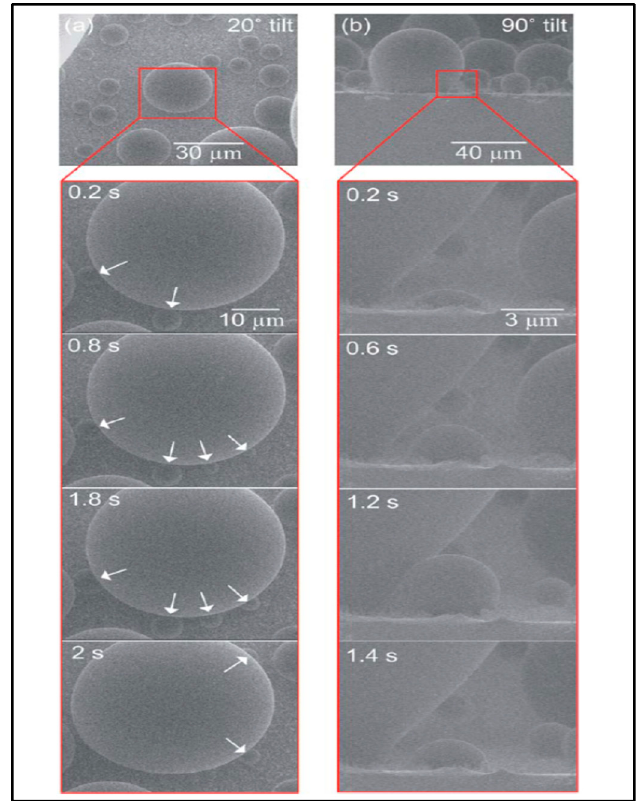
Figure 4. Location of small micro–nanoscale satellite drops adjacent to primary drops as shown by white arrows. Images taken by Environmental Scanning Electron Microscopy (ESEM) at ( a ) 20° and ( b ) 90° tilt on a super hydrophobic condenser surface [5]. Reprinted with permission from Ref. [5]. Copyright 2011 Royal Society of Chemistry.